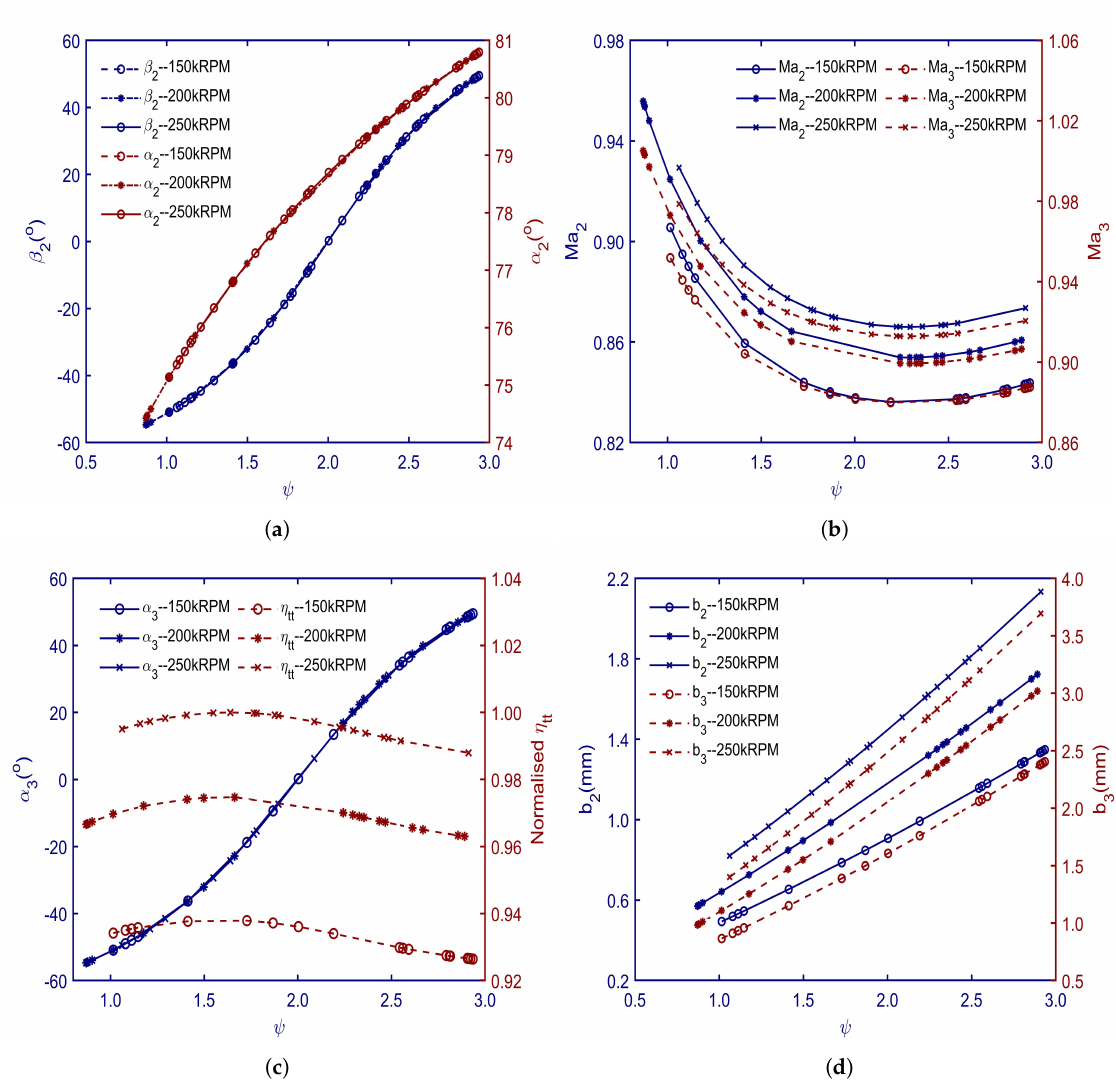
Figure 5. Loading coefficient ( ψ ) versus ( a ) flow angles [ β 2 and α 2 ] ( b ) Mach number at the rotor inlet [Ma 2 ] and exit [Ma 3 ] ( c) normalised efficiency [ η tt ] and swirl angle [ α 3 ] ( d ) blade heights [b 2 and b 3 ] at various rotational